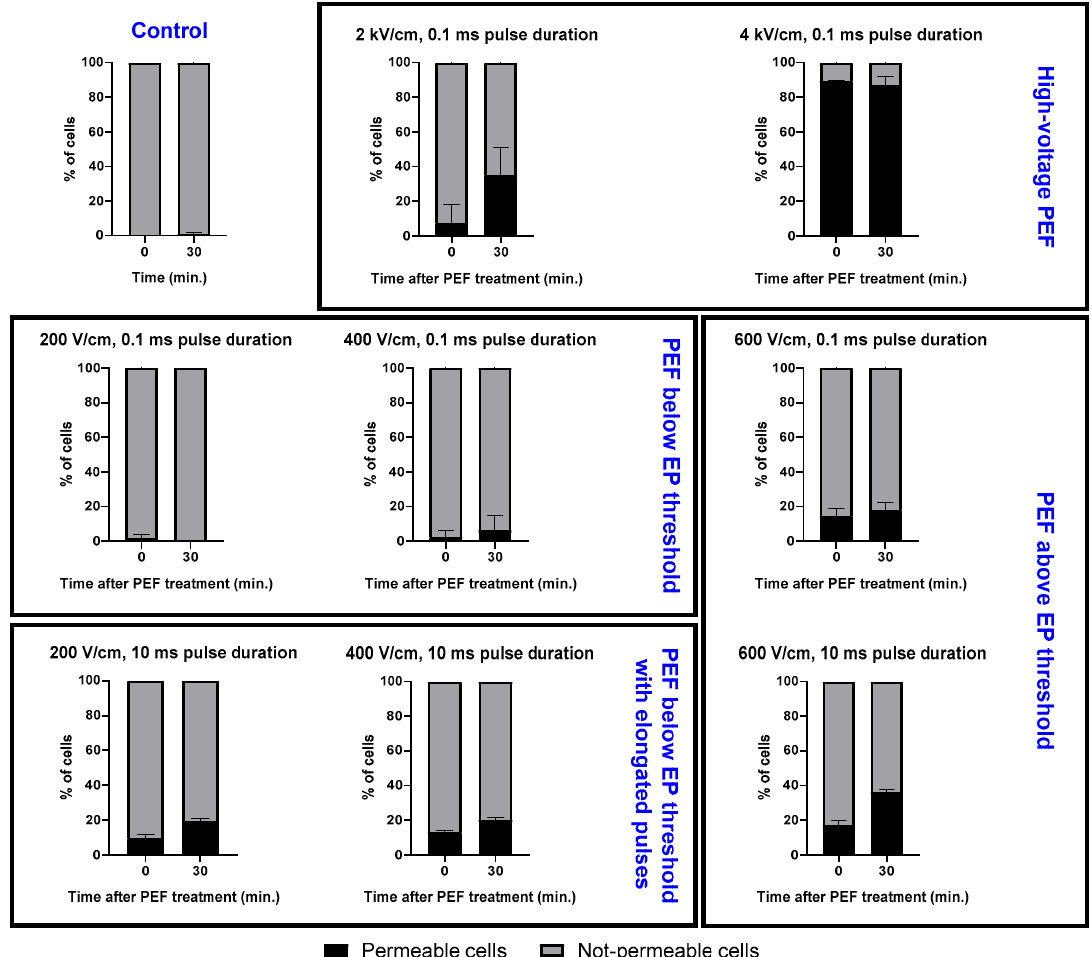
Figure 2. Trypan blue staining shows pore resealing after 30 min. PEFs below the EP threshold induce the pulse-duration- dependent permeabilization for the stain. Data presented as the % of cells ± SD.